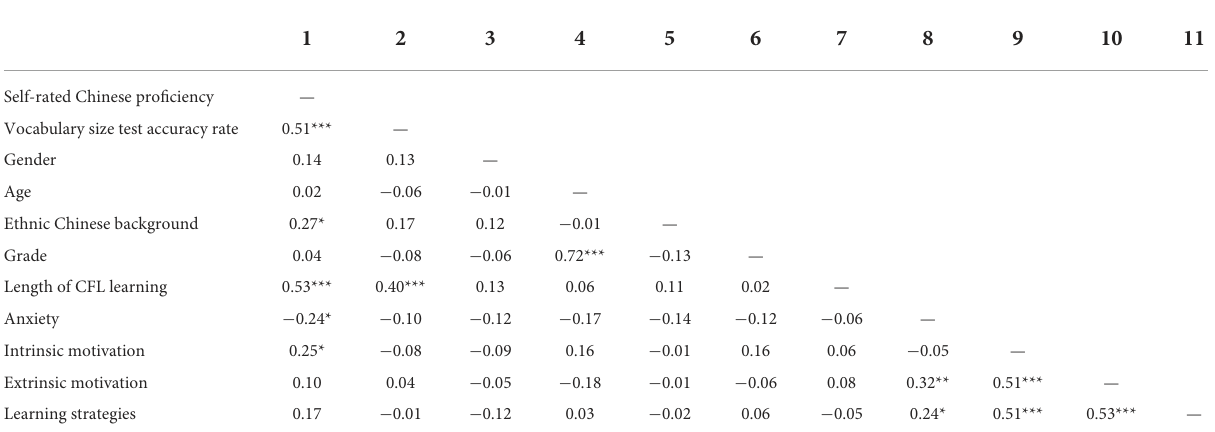
TABLE 4 Correlation matrix between the measured